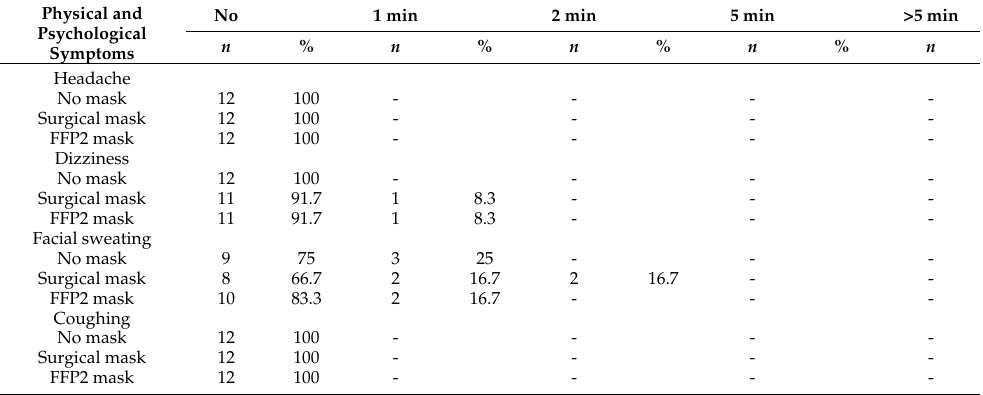
Table 2. Frequencies and response time of physical and psychological symptoms by mask